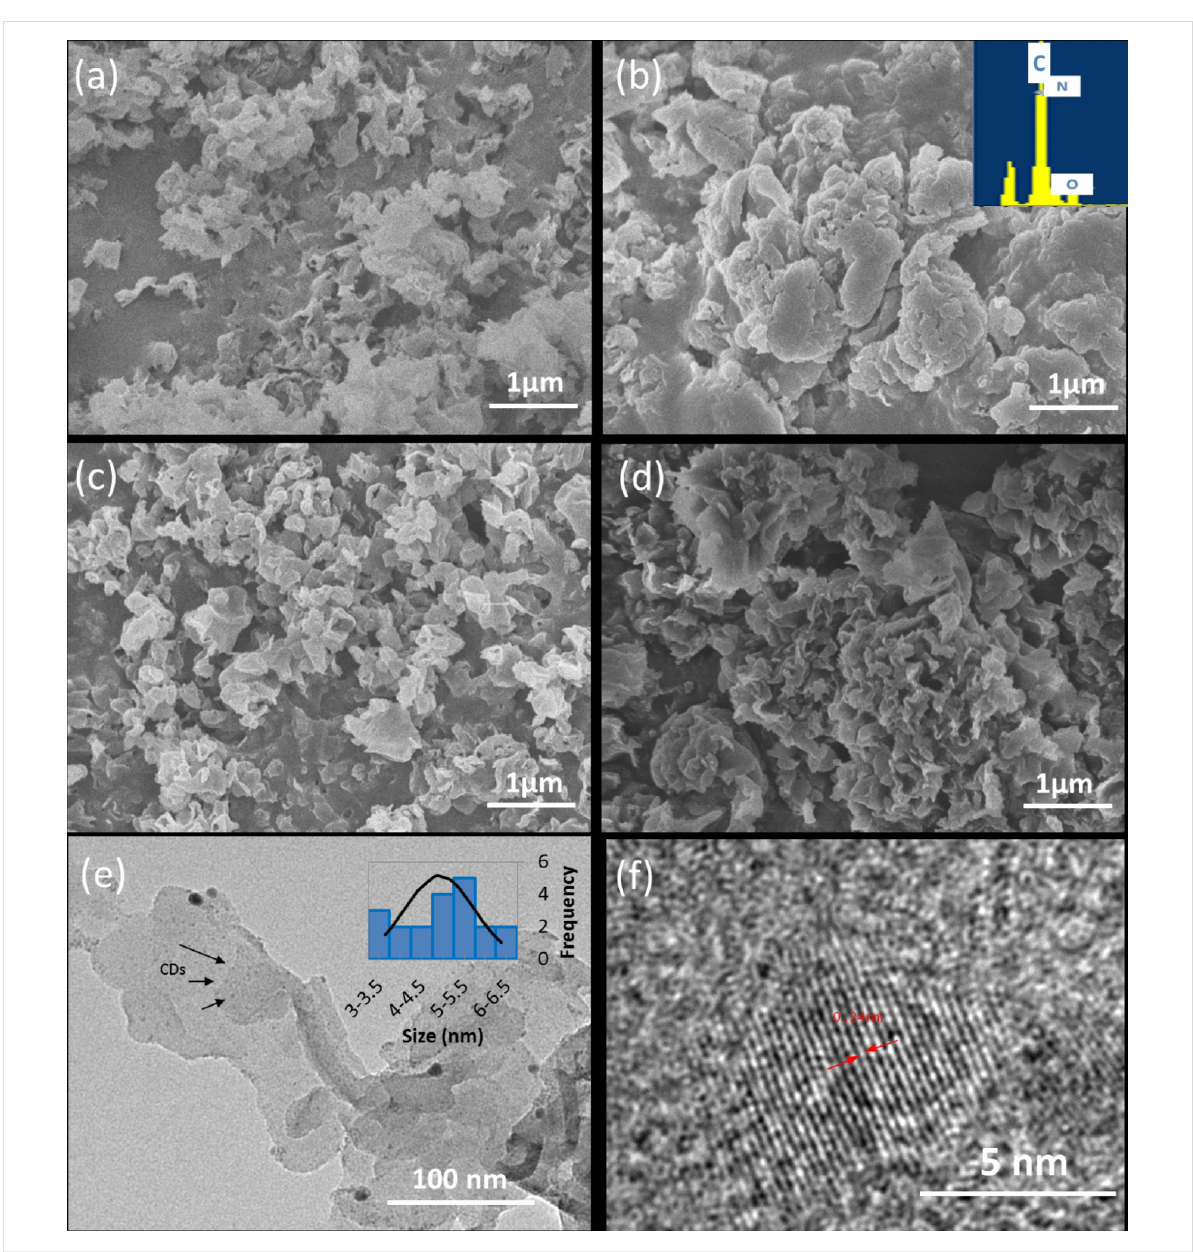
Figure 1: Field emission scanning electron microscopy (FESEM) images of (a) g-C 3 N 4 , (b) CD/g-C 3 N 4 (0.1), (c) CD/g-C 3 N 4 (0.2), and (d) CD/g- C 3 N 4 (0.5) composites. (e) TEM image and (f) HRTEM image of CD/g-C 3 N 4 (0.5). The insets of (b) and (e) show the energy-dispersive X-ray spectros- copy (EDS) results and particle size distribution of CDs,